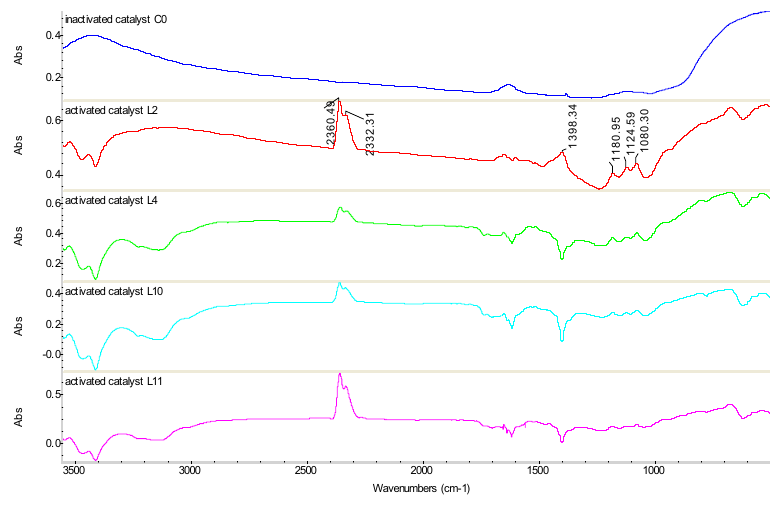
Figure 7. Infrared spectra of catalysts before and after